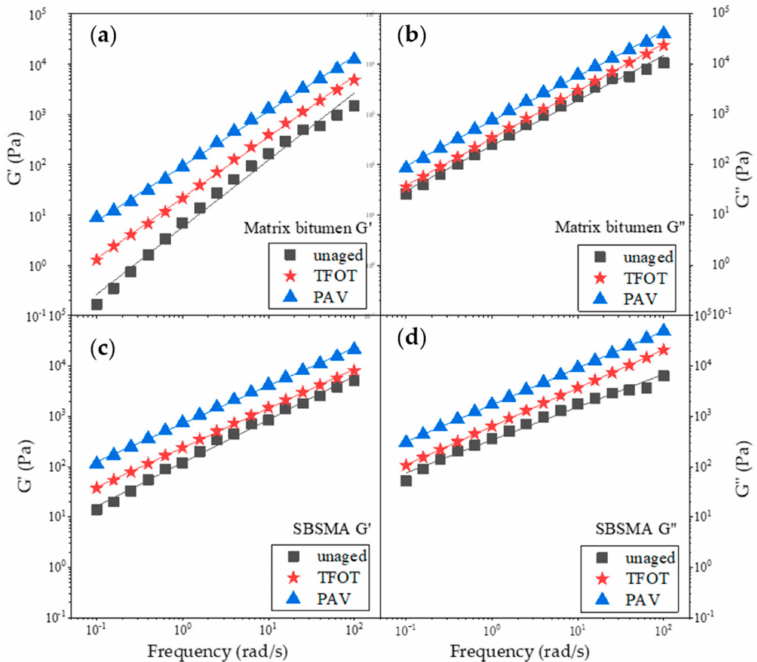
Figure 5. Viscoelastic parameters versus frequency of unaged and aged matrix bitumen and SBSMA at 60 ◦ C. ( a ) Matrix bitumen G (cid:48) ; ( b ) Matrix bitumen G”; ( c ) SBSMA G (cid:48) ; ( d ) SBSMA